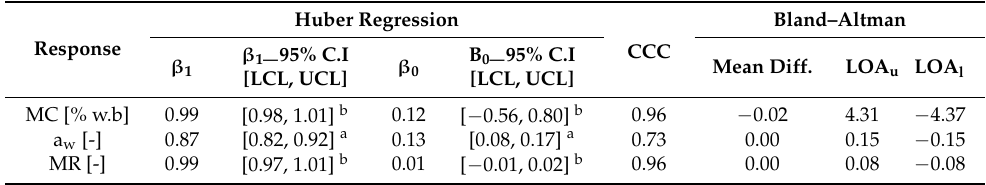
Table 4. Method comparison metrics for moisture attributes.